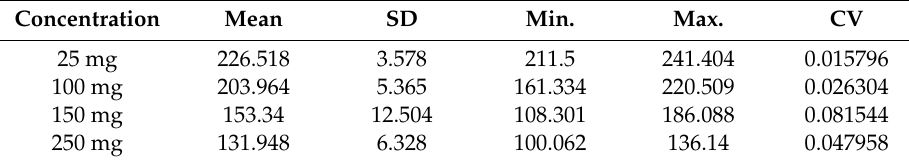
Table 3. Coe ffi cient of variation (CV) of the four ZnCuInS / ZnS / PMMA films. Concentration Mean SD Min.